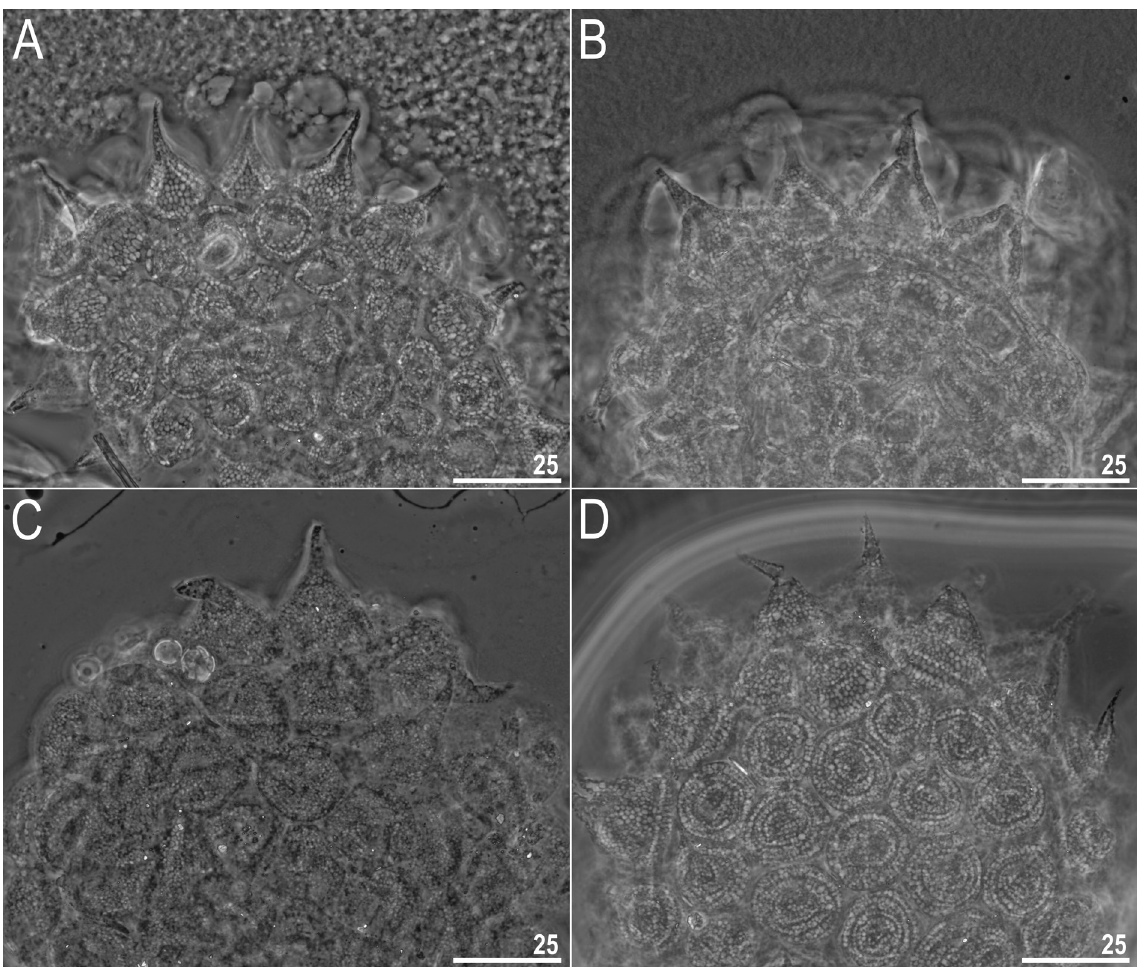
Fig. 24. Tenuibiotus cf. voronkovi (Tumanov, 2007) from the Nordaustlandet population, eggs seen in PCM. Four different eggs under 1000× magnification. Scale bars in